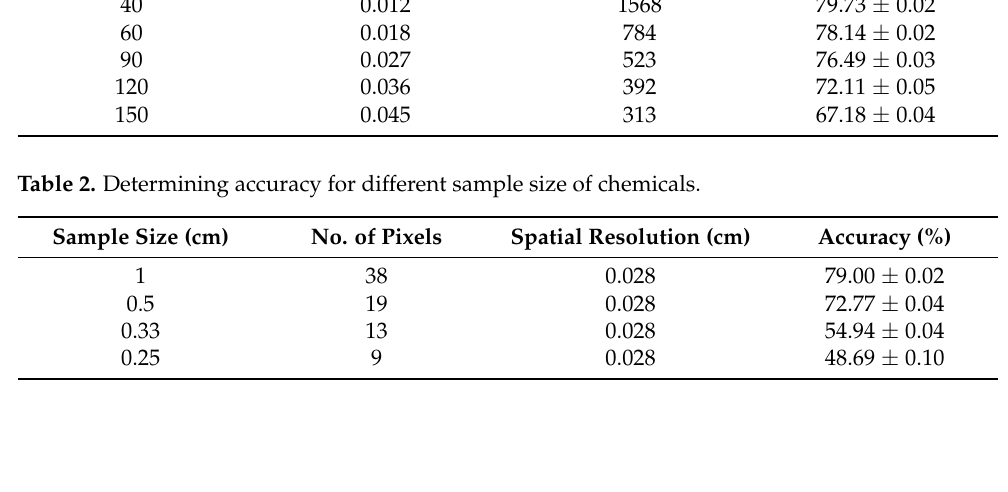
Table 1. Determines the accuracy of chemical at different height of sensors.